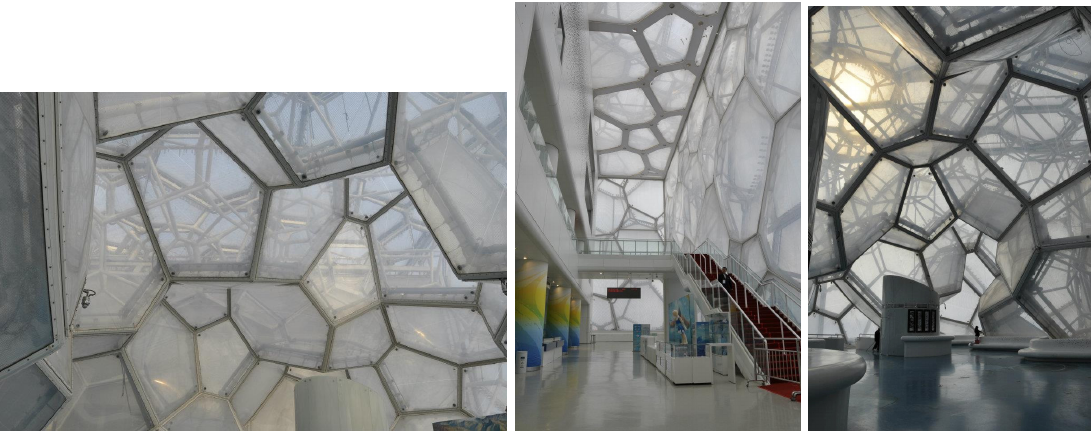
Figure 3. Water Cube Project in Beijing, China, ARUP Associates (Courtesy Terri Boake, University of Waterloo).